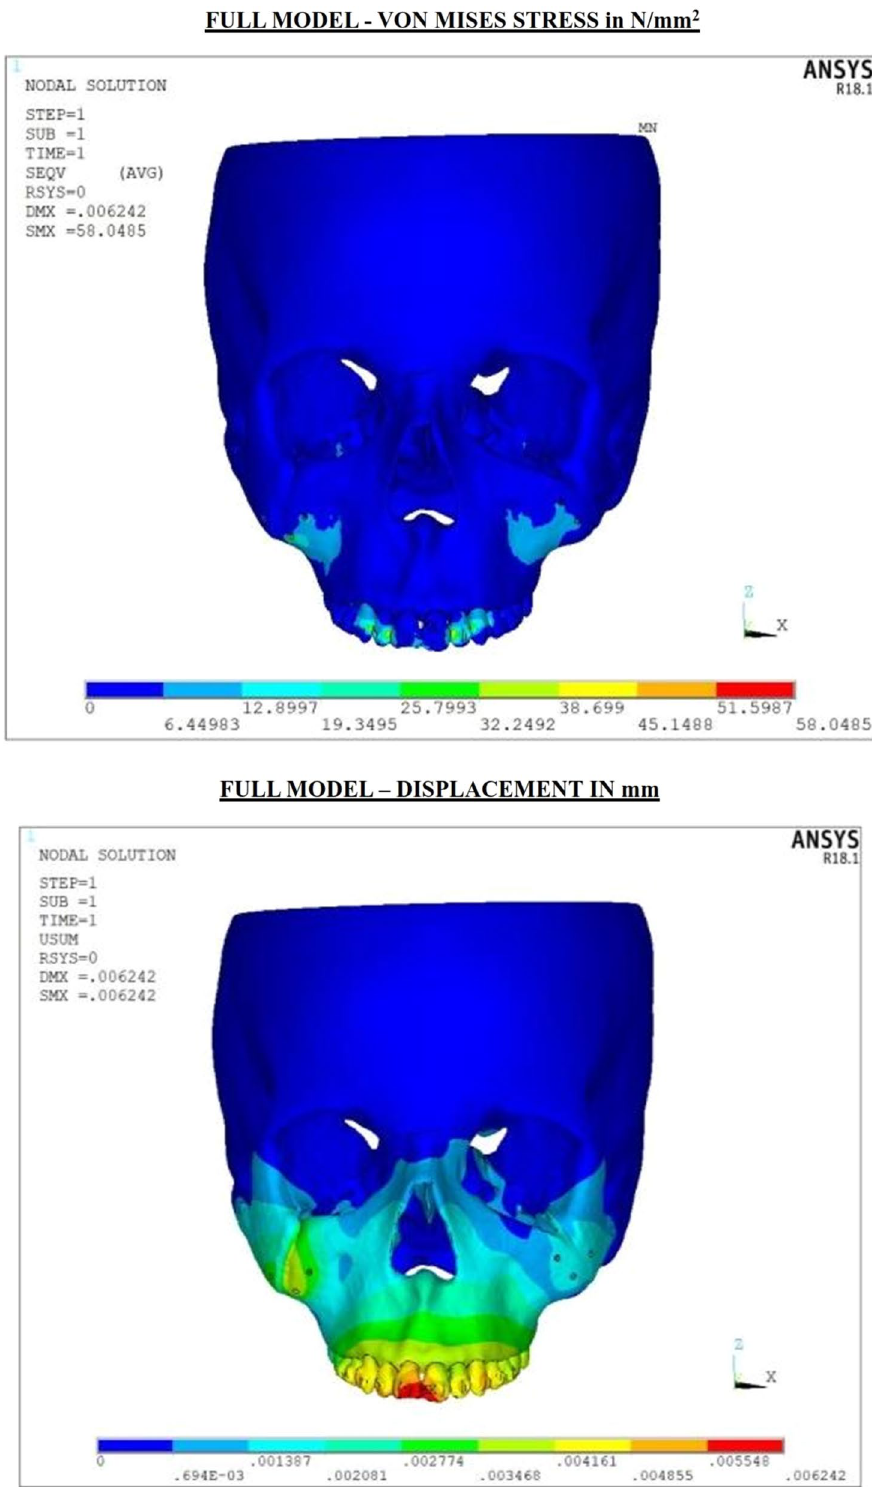
Fig. 3 Stress and displacement plots in full model with miniplates for 500 g of